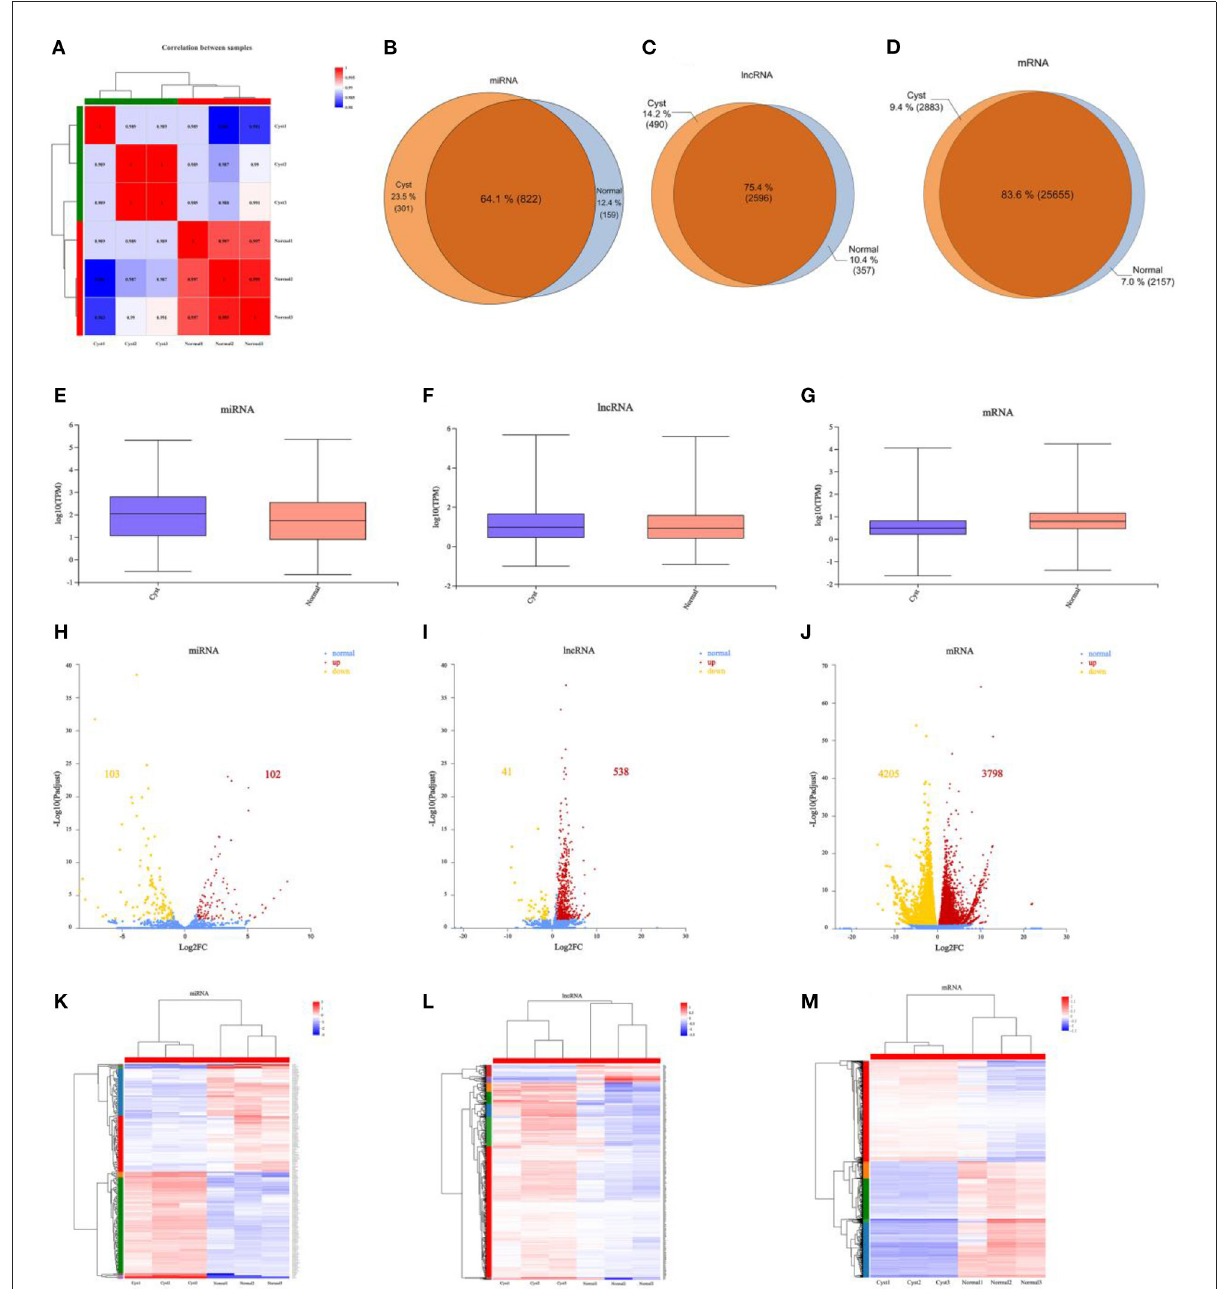
FIGURE2 Comparative analysis of mRNAs, miRNAs and lncRNAs between normal and cystic follicular GCs. (A) : Correlation analysis between samples. (B–D) : The specific miRNAs, lncRNAs and mRNAs shared between normal and cystic follicular GCs. (E–G) : Boxplots showing the expression distribution of miRNAs, lncRNAs and mRNAs. (H–J) : Volcano plot of DE miRNAs, DE lncRNAs and DE mRNAs in normal and cystic follicular GCs. (K–M) : Hierarchical clustering of DE miRNAs, DE lncRNAs and DE mRNAs in normal and cystic follicular GCs. The red points showed the up-regulated miRNAs, lncRNAs and mRNAs, the yellow points showed the downregulated miRNAs, lncRNAs and mRNAs, and the blue points showed the equally expressed miRNAs, lncRNAs and mRNAs in volcano plots. Normal: Bovine ovarian follicles between 10–15 mm in diameter. Cyst: Bovine ovarian follicles greater than 25mm in